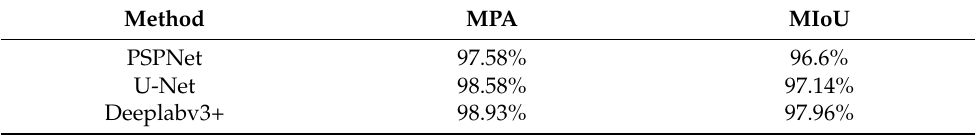
Table 2. Results of different segmentation